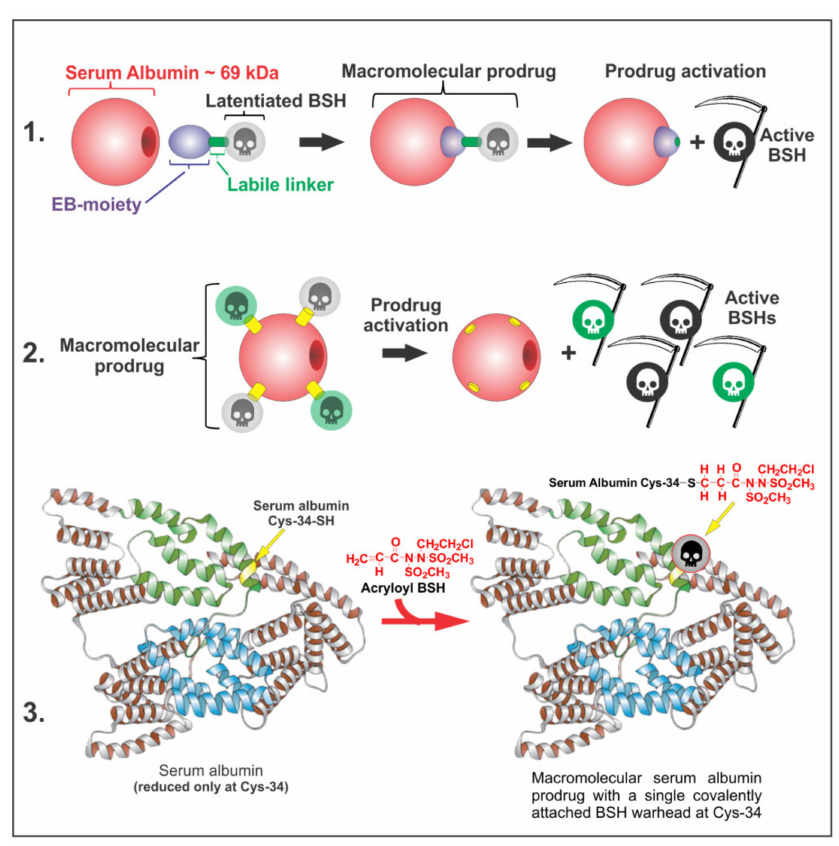
Figure 3. Proposed designs for EPR targeted macromolecular BSH prodrugs. ( 1 ). Design